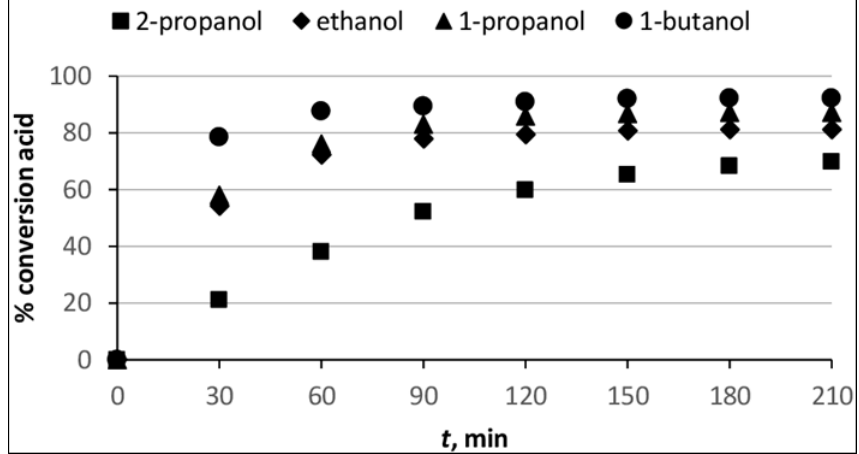
Figure 1. Influence of the chain length and structure of the alcohol on esterification of propanoic acid. Conditions: acid/alcohol/catalyst (H